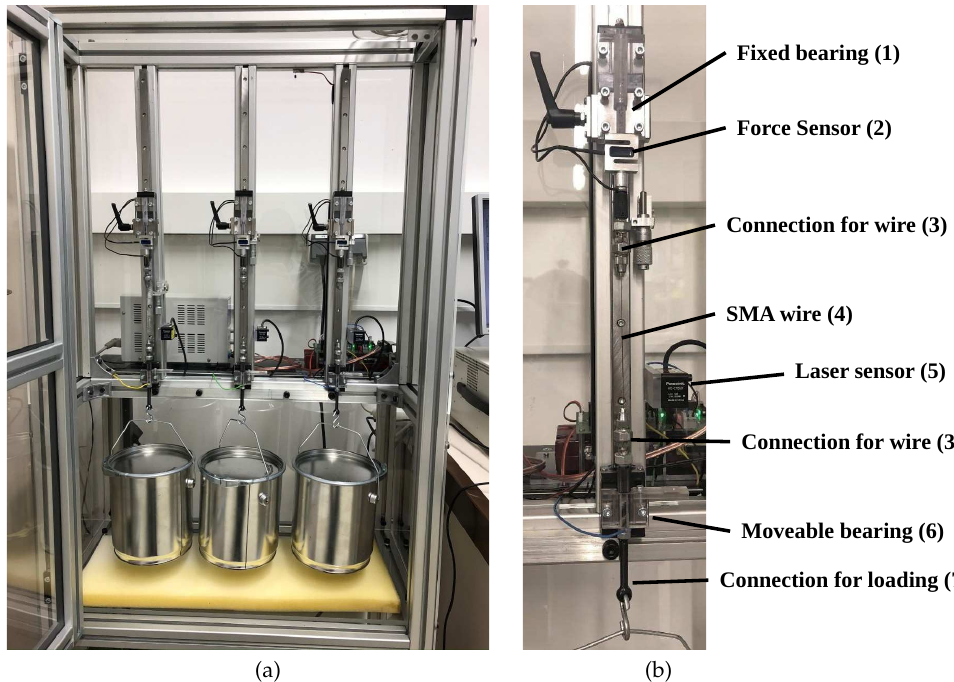
Figure 5. Test rig for fatigue tests of 3 SMA wires with weight as the resetting element ( a ) Complete test rig; ( b ) Detailed view of 1 test channel. Source: